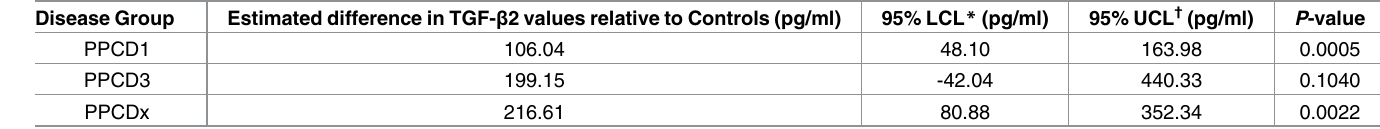
Table 2. Analysis of variancebased on the unadjusted model for the active TGF- β 2 values in individual PPCD groups. Disease Group Estimated difference in TGF- β 2 values relative to Controls (pg/ml)